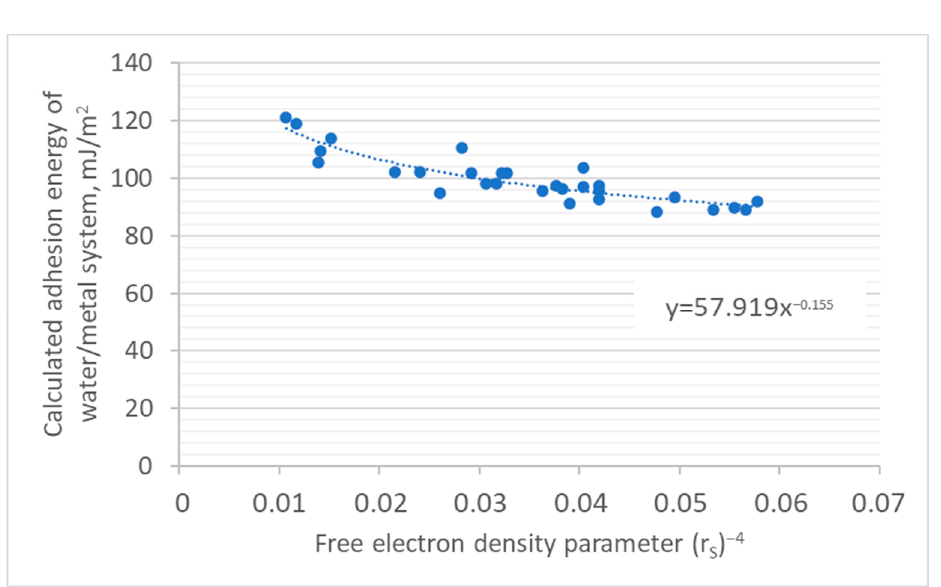
Figure 7. Adhesion energy (W) as a function of the free electron density parameter following the W~f(r S − 4 )